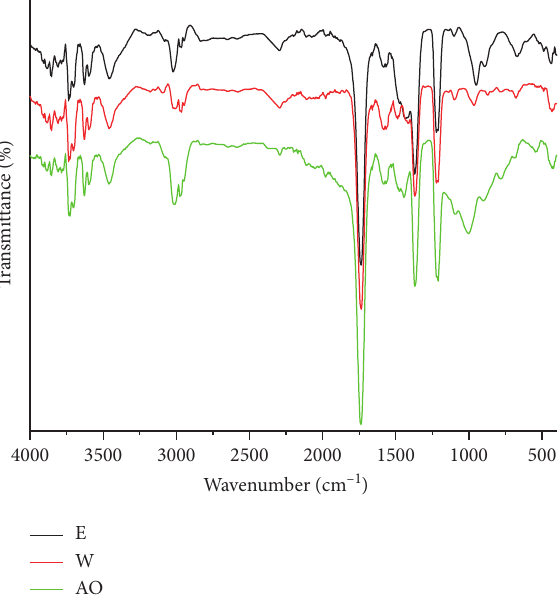
Figure 9: FT-IR image of 2.5 M and 1 :3 of SH: SS.